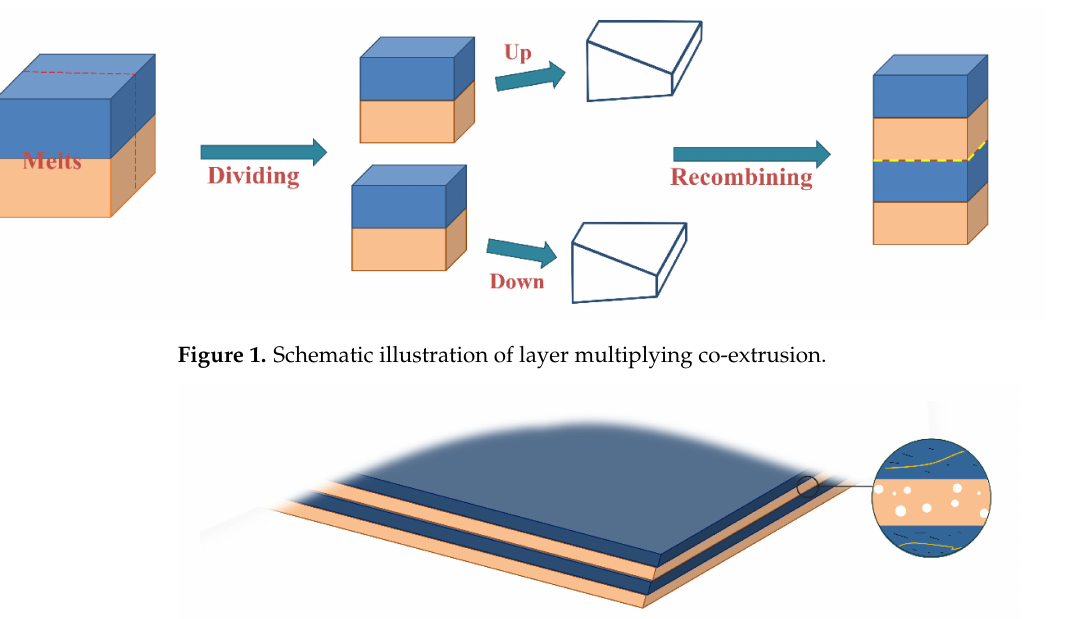
Figure 2. Schematic diagram of the multilayer EPDM